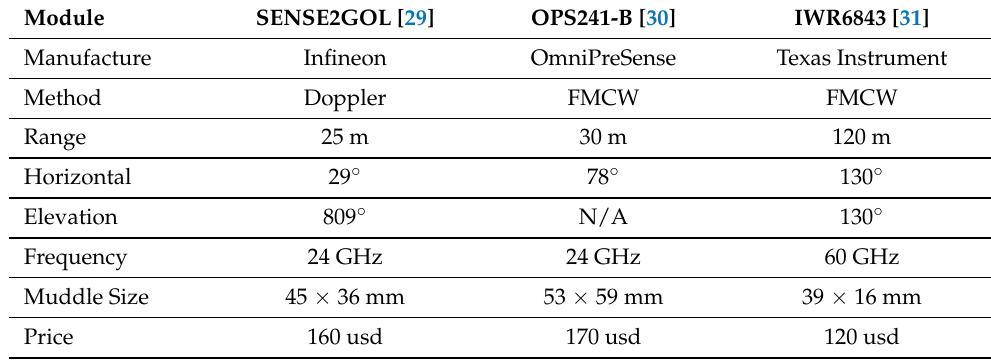
Table 1. Specifications of radar modules.